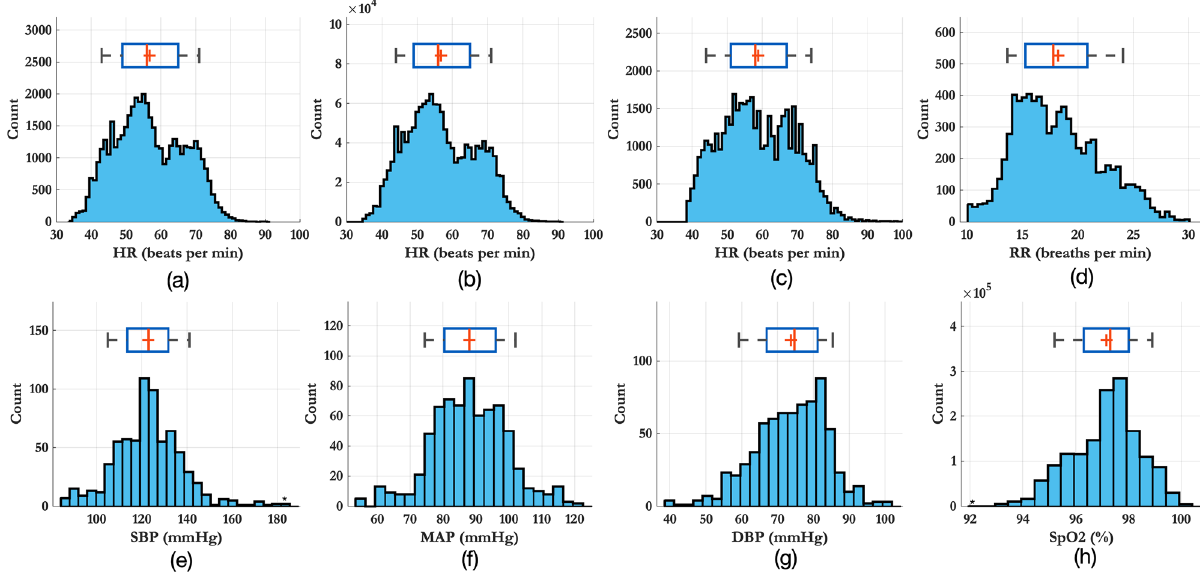
Figure 1. Distribution of physiological values recorded across the entire study in our dataset for all the volunteers: ( a ) heart rate from the Philips monitor, ( b ) heart rate from the Stowood device, ( c ) heart rate from the CardioScreen device, ( d ) respiratory rate estimated from the nasal cannula, ( e ) SBP from the Philips BP cuff, ( f ) MAP from the Philips BP cuff and ( g ) DBP from the Philips BP cuff, ( h ) SpO 2 from the Philips